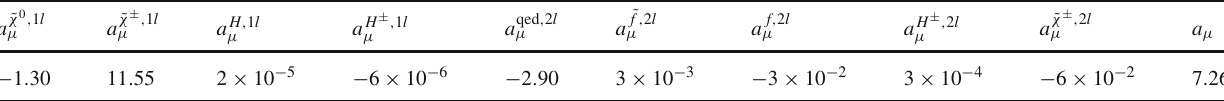
Table 3 The individual contributions to the muon AMM in the NMSSM without inverse seesaw mechanism. The total sum is given in the last column. All values are normalized to 10 − 10 ˜ χ 0 , 1 l a